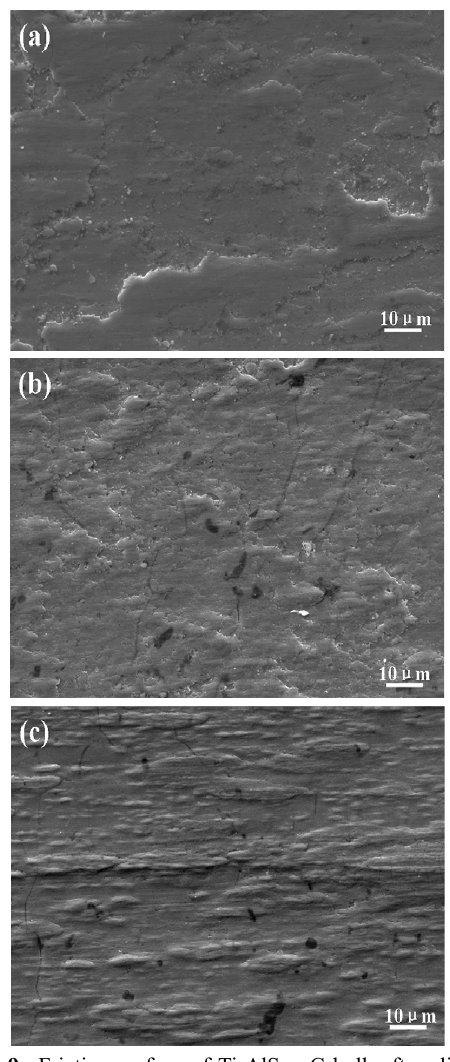
Fig. 9 Friction surface of Ti 2 AlSn 0.2 C bulk after sliding friction of (a) 10 m/s and 80 N, (b) 20 m/s and 80 N, (c) 30 m/s and 80 N.